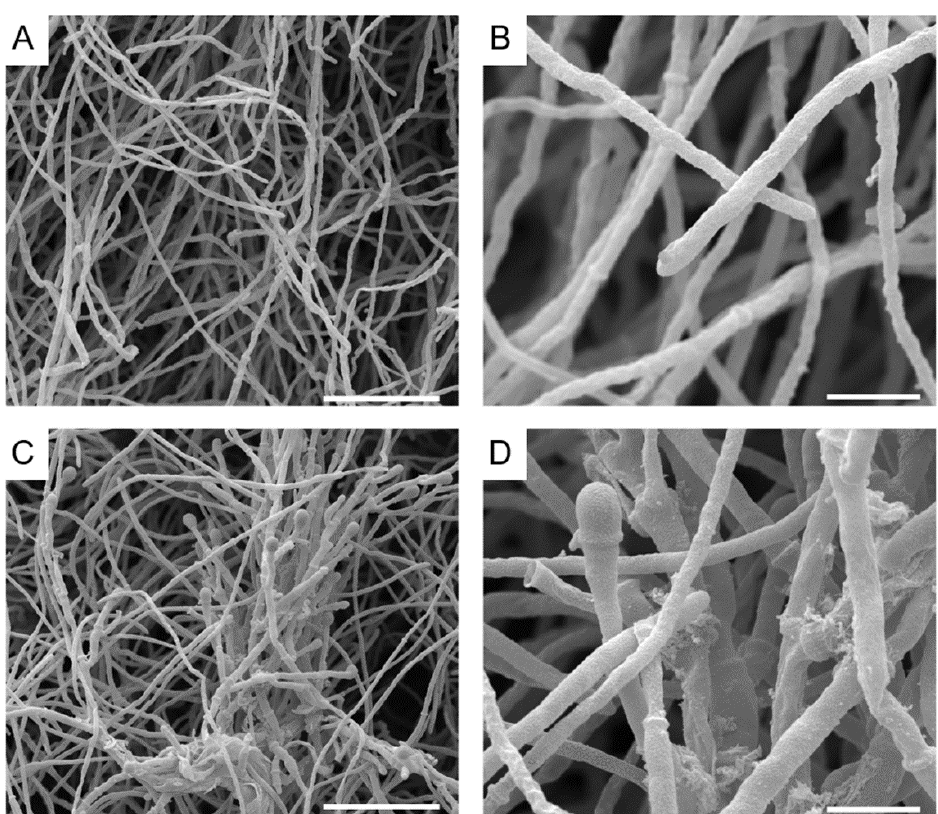
Figure 5. Ultrastructural alterations of S. aurantiacum CBS 136046 on exposure to auranofin, evaluated by scanning electron microscopy. Untreated cells exhibit septated hyphae ( A , B ), while samples treated with 2.5 μ m auranofin for 48 h show alterations in fungal surface ( C , D ). Bars: 25 μ m ( A , C ) e 5 μ m ( B , D ).